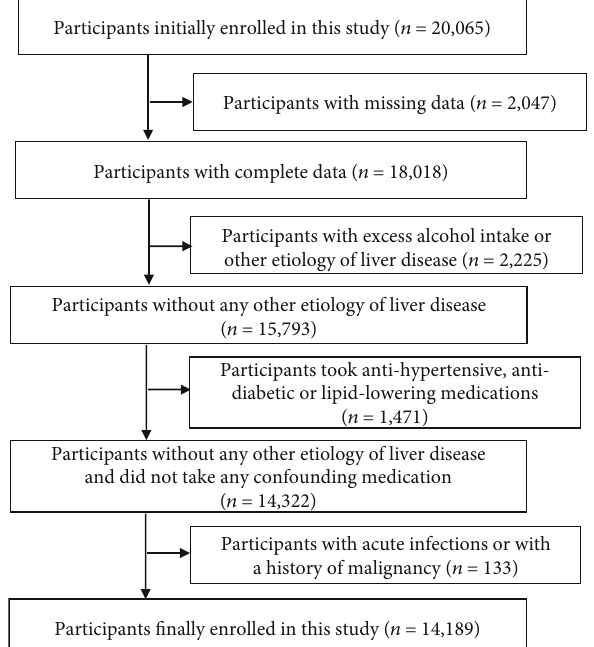
Figure 1: Flowchart of the